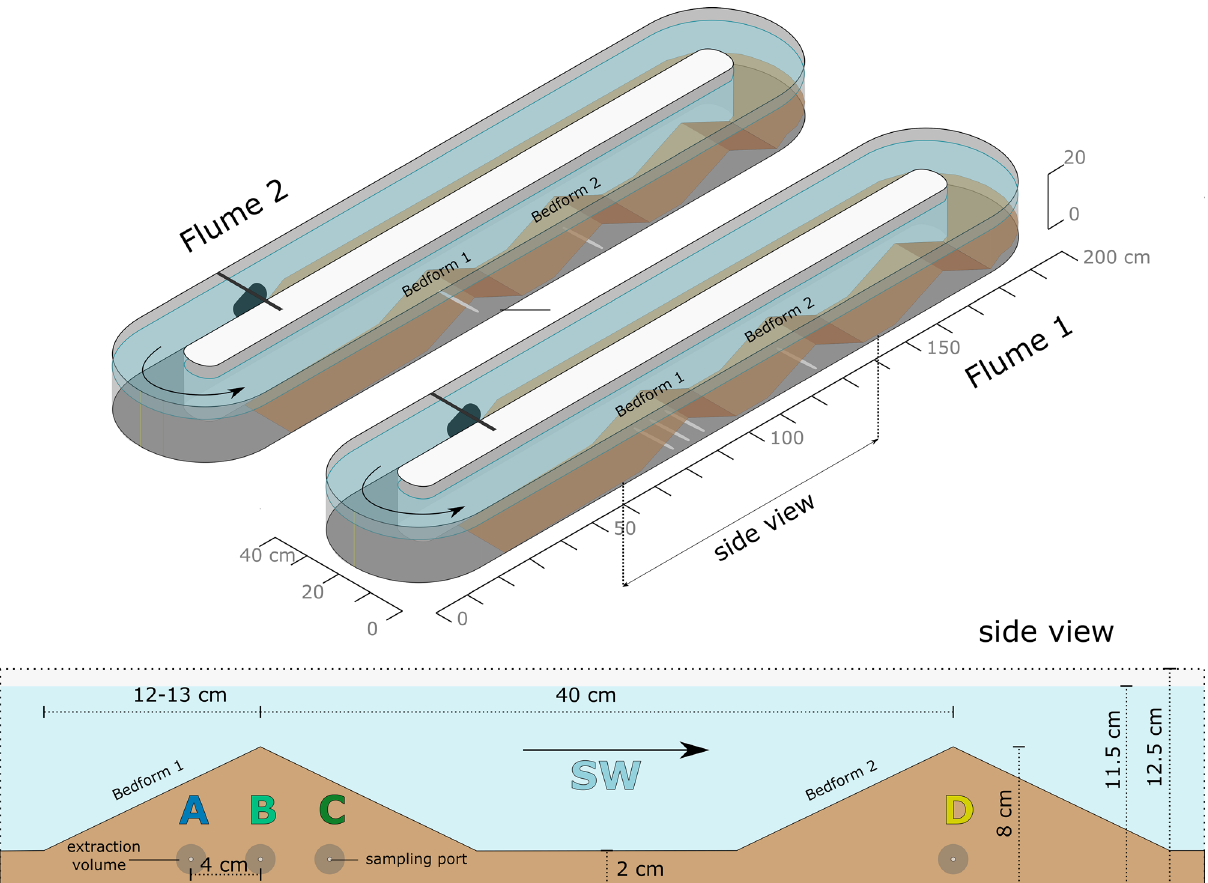
Figure 1. Schematic of Flumes 1 and 2. Flume 1 held porewater samplers in positions A, B, C and D. Flume 2 held porewater samplers in positions B and D. The measures represent ideal conditions obtained after bedform formation. Figure adapted from Jaeger et al. 35 .